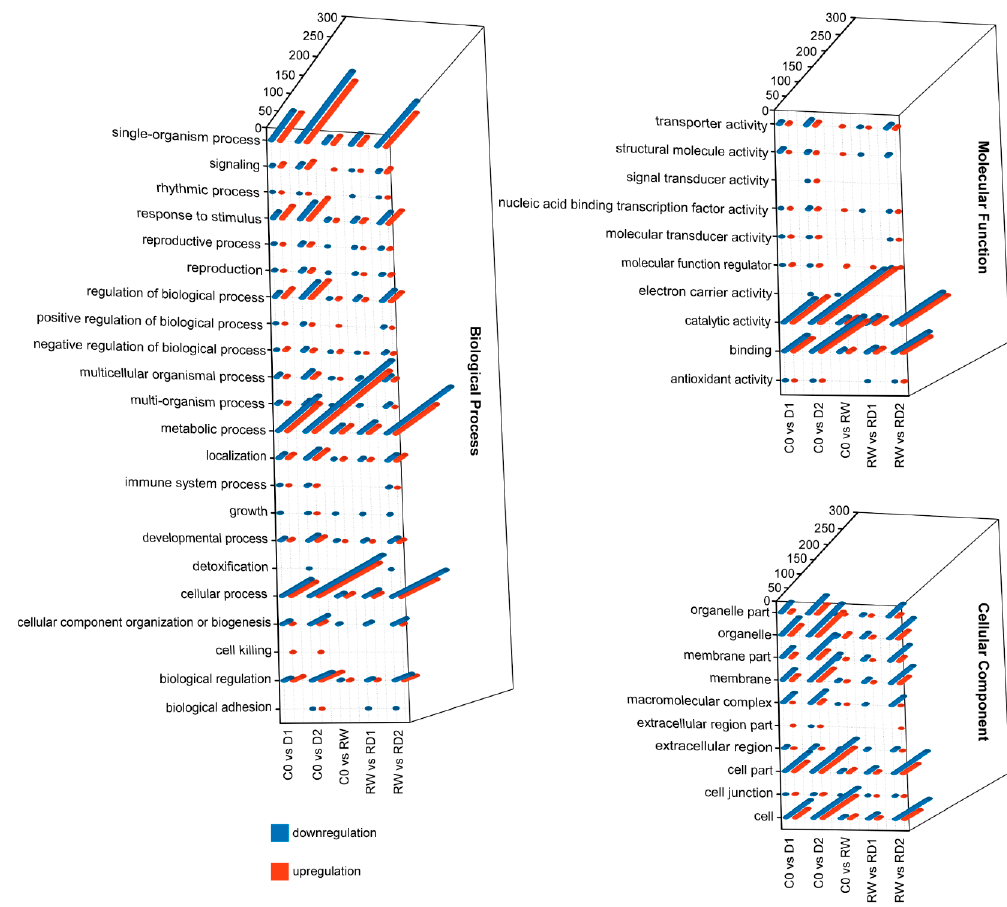
Figure 2. The gene ontology (GO) enrichment of DEGs in response to drought and re-dehydration in potato. The blue columns indicate the numbers of downregulation genes, while the red columns indicate the numbers of upregulation genes.